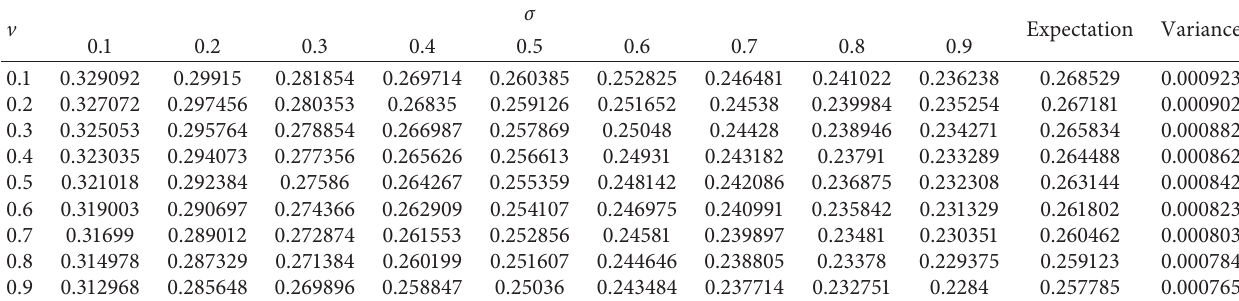
A under the WS small-world network.